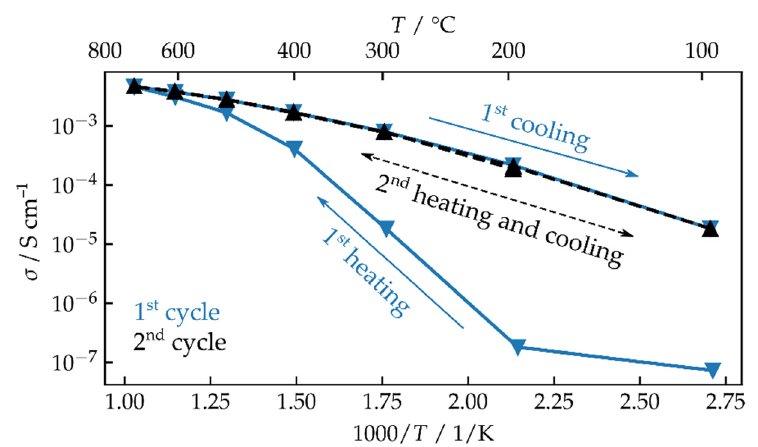
Figure 7. Electrical conductivity during two thermal annealing cycles.